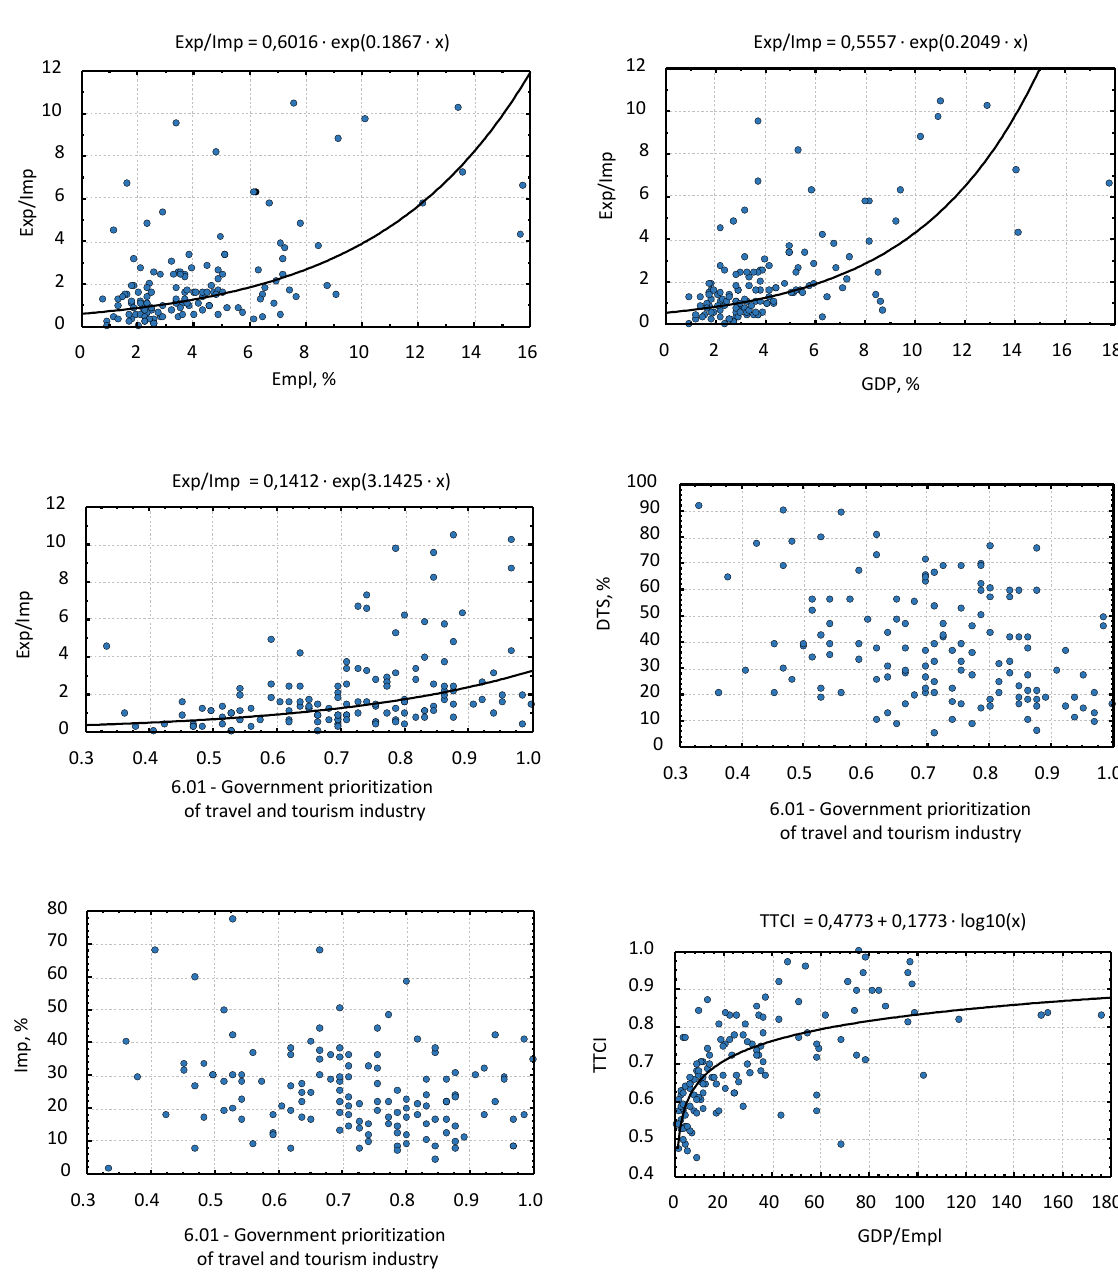
Figure 1 (cont.). Correlation-regression analysis